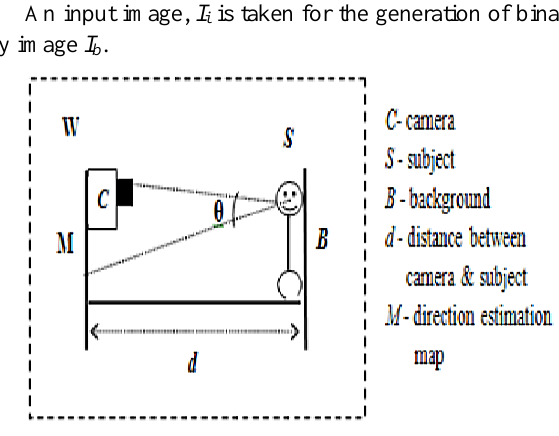
Figure 2: Experimental setup for analysis of GDE